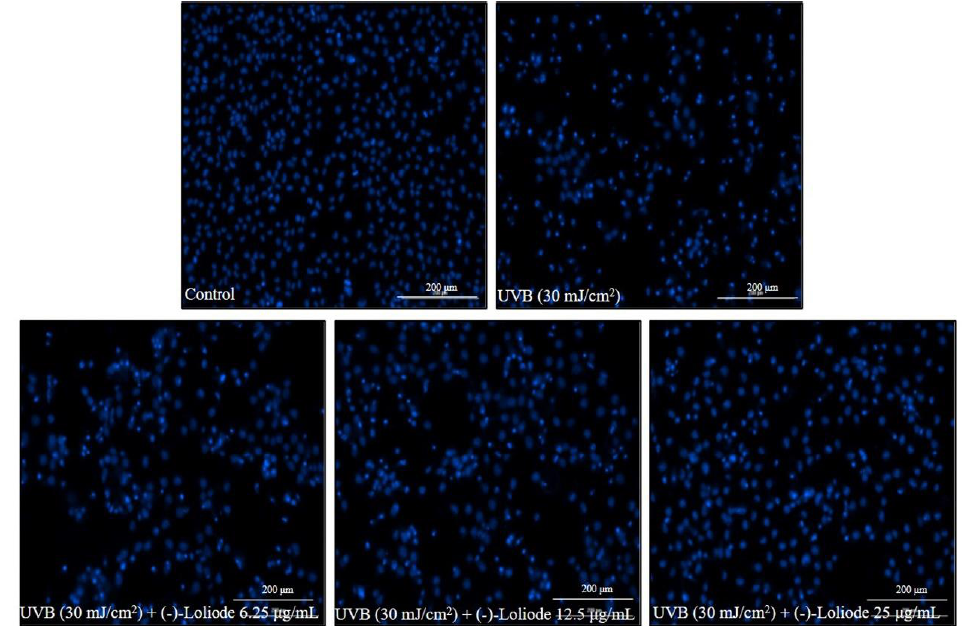
Figure 3. Protective effect of (-)-loliode against UVB-induced apoptosis in HaCaT cells. The apoptotic body formation was evaluated by Hoechst 33342 staining assay.